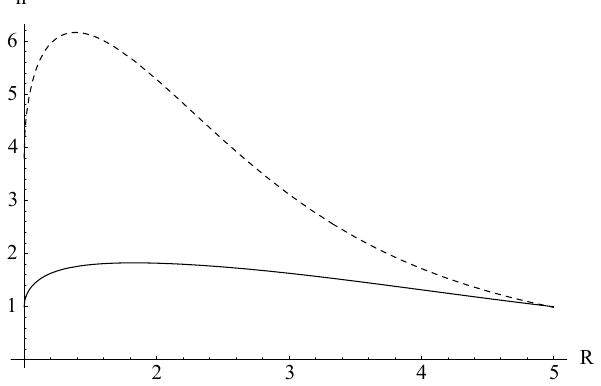
Fig. 1. The quantity n e (m), extra given by Eq. (7) as a function of radial distance R (in units of Earth radius) for T k /T ⊥ = 2 (solid line) and T k /T ⊥ = 8 (dashed line). Normalisation is such that n at R = 5.